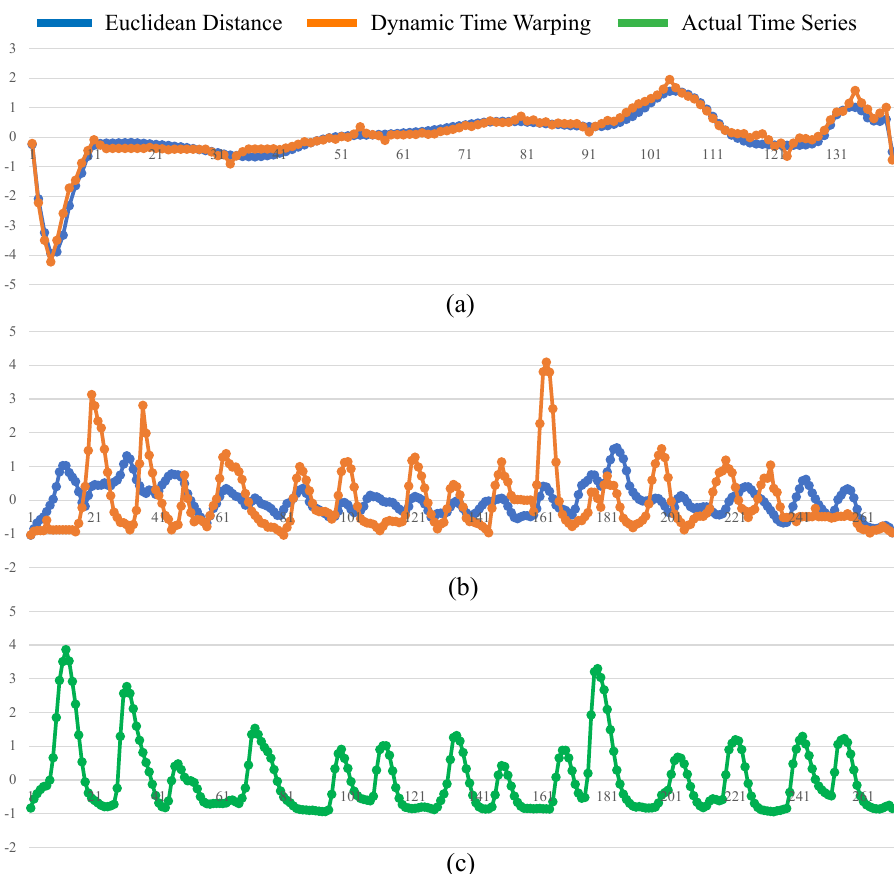
Figure 7. Average sequences obtained by Euclidean Distance and DTW distance in ECG5000 dataset ( a ) and FiftyWords dataset ( b ). ( c ) The actual time-series in the FiftyWords